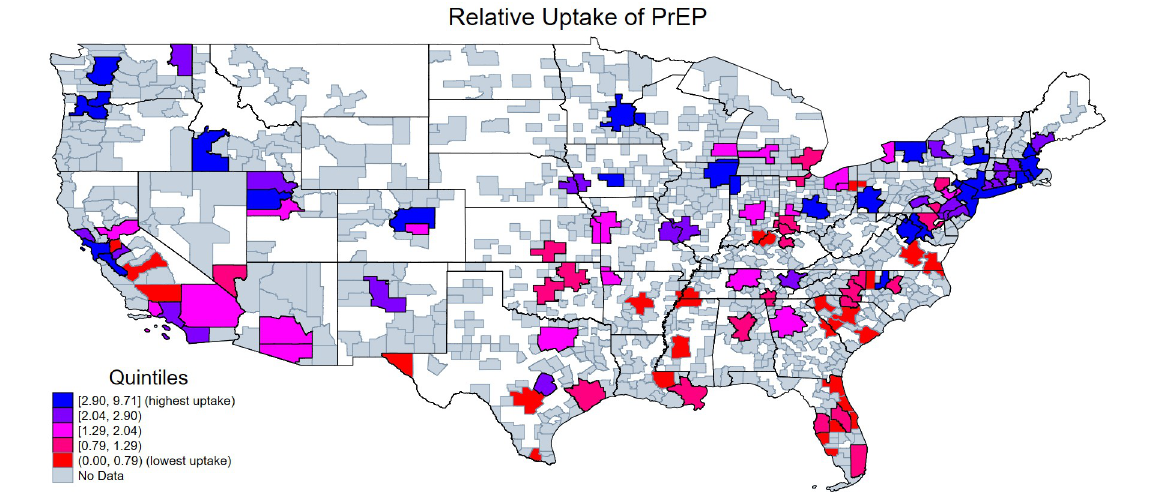
Fig 2. Relative uptake of PrEP by MSA for MSAs with populations of 500,000 or greater. Source: Authors’ analysis of the IDV data from September 2015 to August 2016 and CDC’s 2015 Annual HIV Surveillance Report. The authors used a shapefile, rather than a basemap, of the